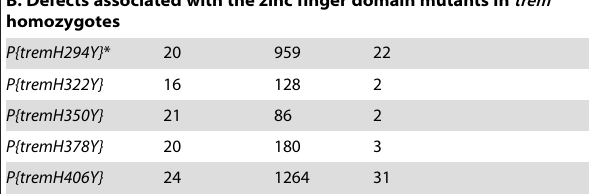
Table 2. Segregation and fertility defects associated with trem mutants. Genotype % X ND a N b Avg. # progeny/ female A. Defects associated with the linker domain mutants in trem f05981 homozygotes B. Defects associated with the zinc finger domain mutants in trem f05981 homozygotes